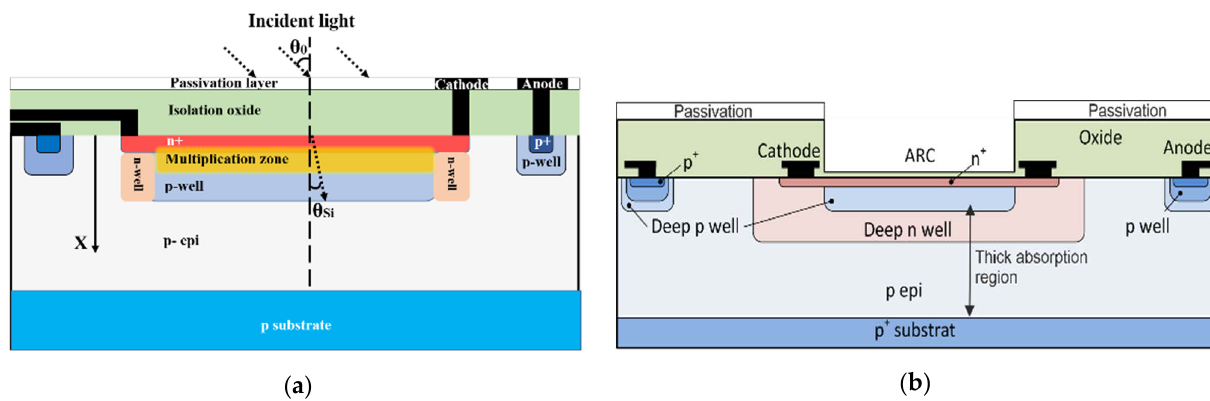
Figure 1. Cross sections of integrated APDs. ( a ) Pin-photodiode (Bi)CMOS APD. ( b ) high-voltage CMOS APD. The block-diagram of the 800 µ m-APD receiver is shown in Figure 2a. The dummy Via pin-photodiode APDs, with diameters of 200, 400 and 600 µm, we ended up with transimpedance amplifier (TIA) adjusts the reference voltage for the differential limit- an 800 µm-diameter APD integrated in a 0.35 µm BiCMOS receiver [30]. A segmentation ing amplifier and, together with the operational transconductance amplifier (OTA) in of the large-area APDs for high data rates as it was used in [32] was not necessary. proportional integral (PI)-controller configuration, elimination of offset voltages and of photocurrent from background light is achieved. Noise of the dummy TIA is reduced by